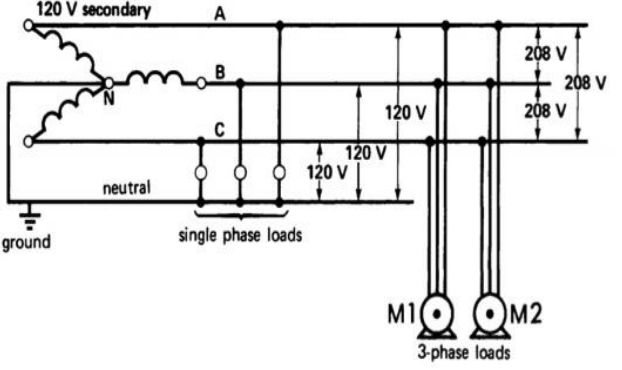
Figure 3. Three Phase Load Configuration.